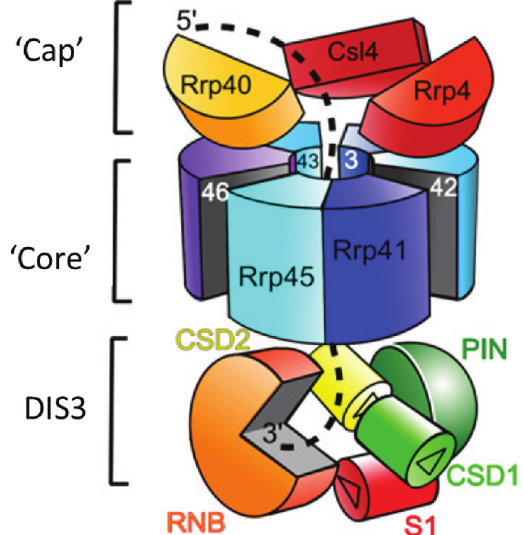
Figure 2. The exosome complex in association with DIS3. The inactive “core” exosome consists of nine subunits. Three subunits form an RNA binding “cap” structure (shades of red/orange). The remaining six subunits form a ring structure through which the RNA substrate is channeled (shades of blue). The exosome gains its activity by association with DIS3 at base of the ring structure. Adapted with permission from Luisi, B. Structure 2009 , 17 , 1429–1431, doi:10.1016/j.str.2009.10.006